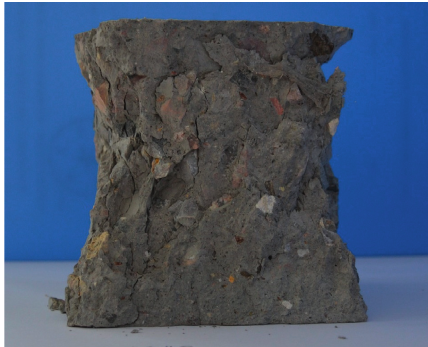
Figure 5: Axial compression failure mode image of